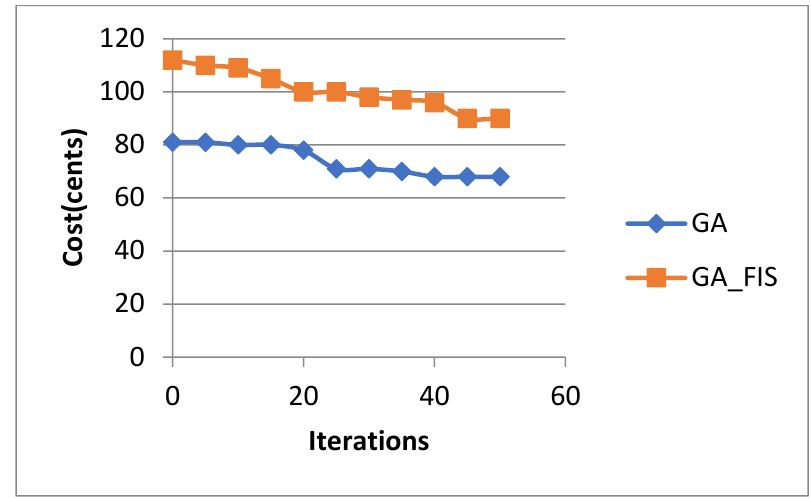
Figure 24. Fitness evolution graphs of GA_FIS and GA for smart load 4.